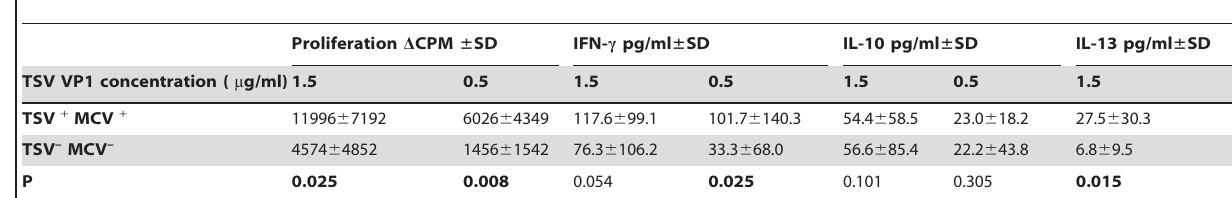
Table 4. Comparison of TSV-specific proliferation and cytokine responses among TSV + MCV + and TSV – MCV –